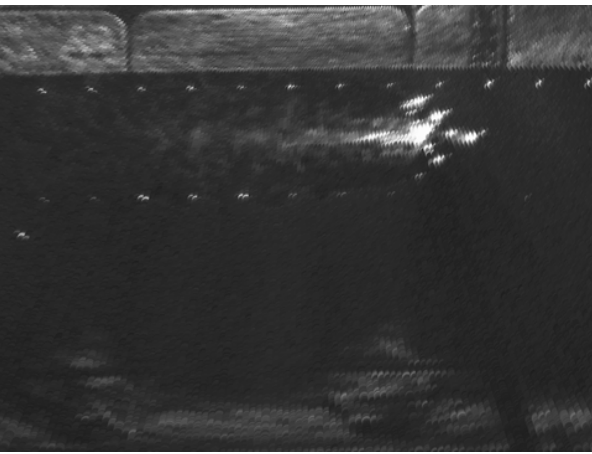
Figure 12. Linear cell radar image [6].